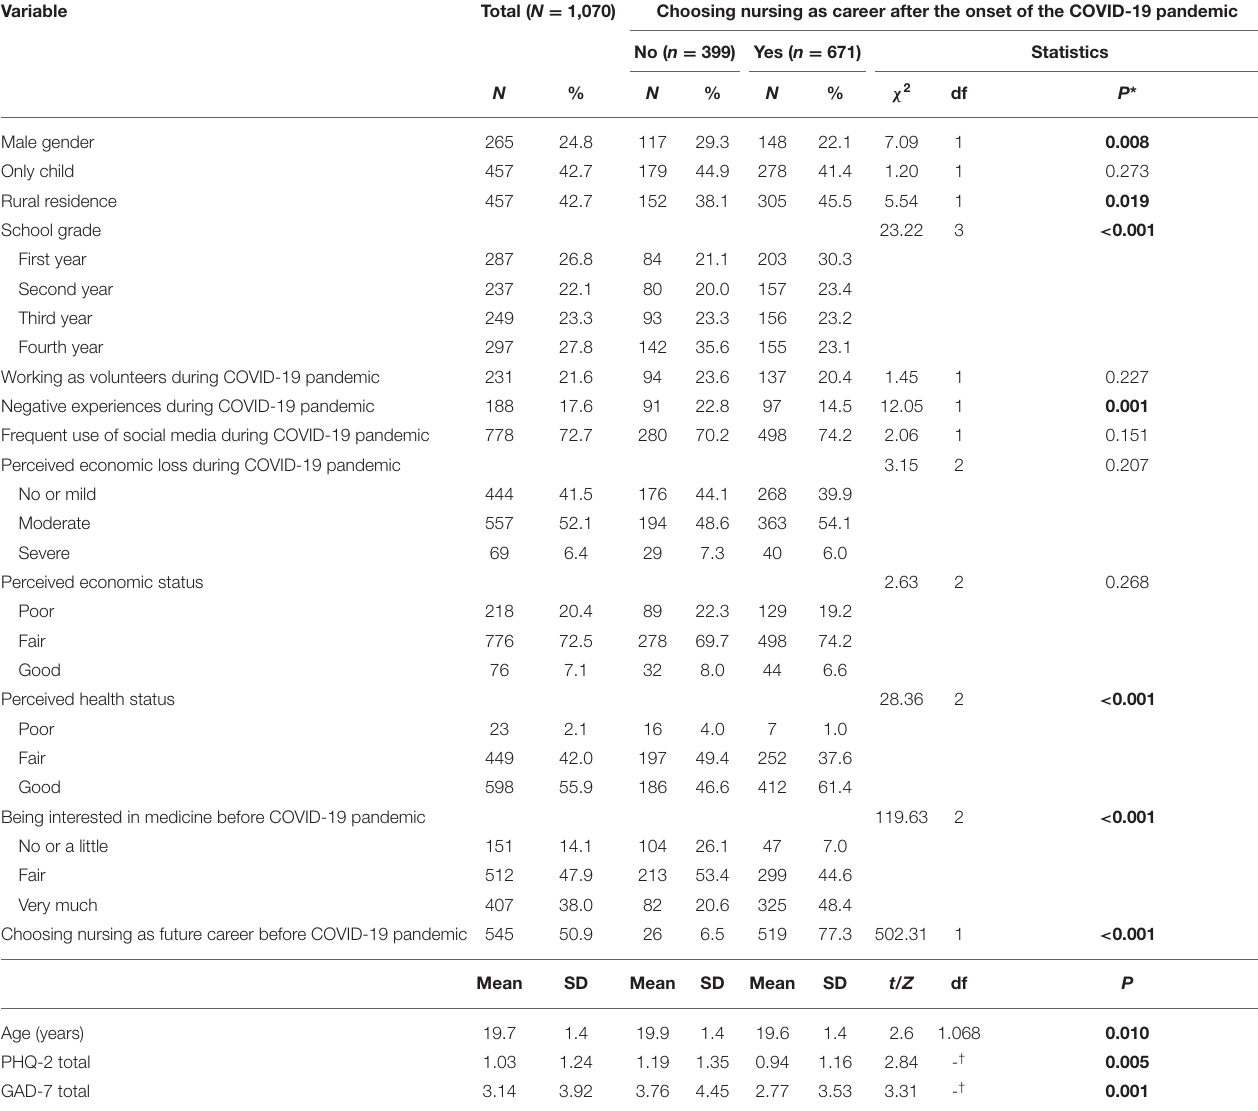
TABLE 1 | Sociodemographic and clinical characteristics of the participants.